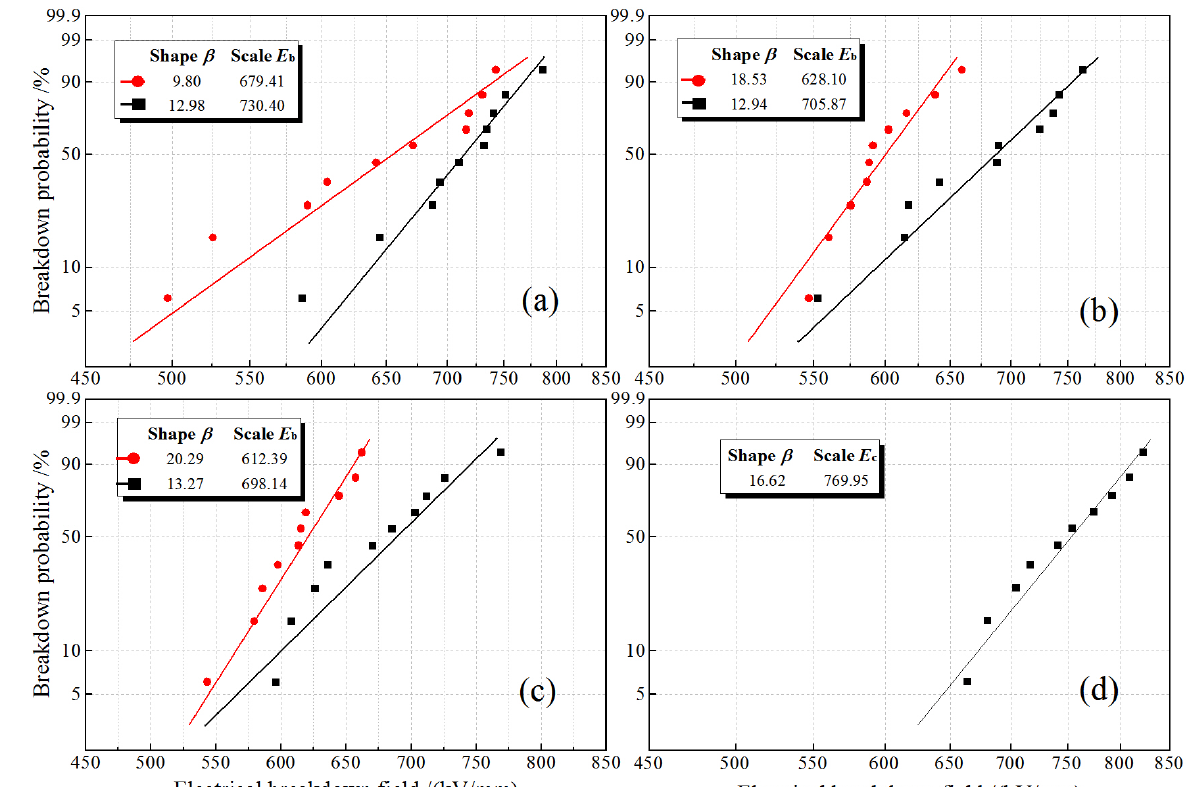
Figure 5. Electrical breakdown fields under DC voltage fitted with two ‐ parameter Weibull statistics for the PET film samples after being applied with DC electric fields of ( a ) 25 kV/mm, ( b ) 75 kV/mm, and ( c ) 100 kV/mm using e ‐ electrode (red sphere) or i ‐ electrode (black square), and ( d ) without pretreatment of applying voltage.